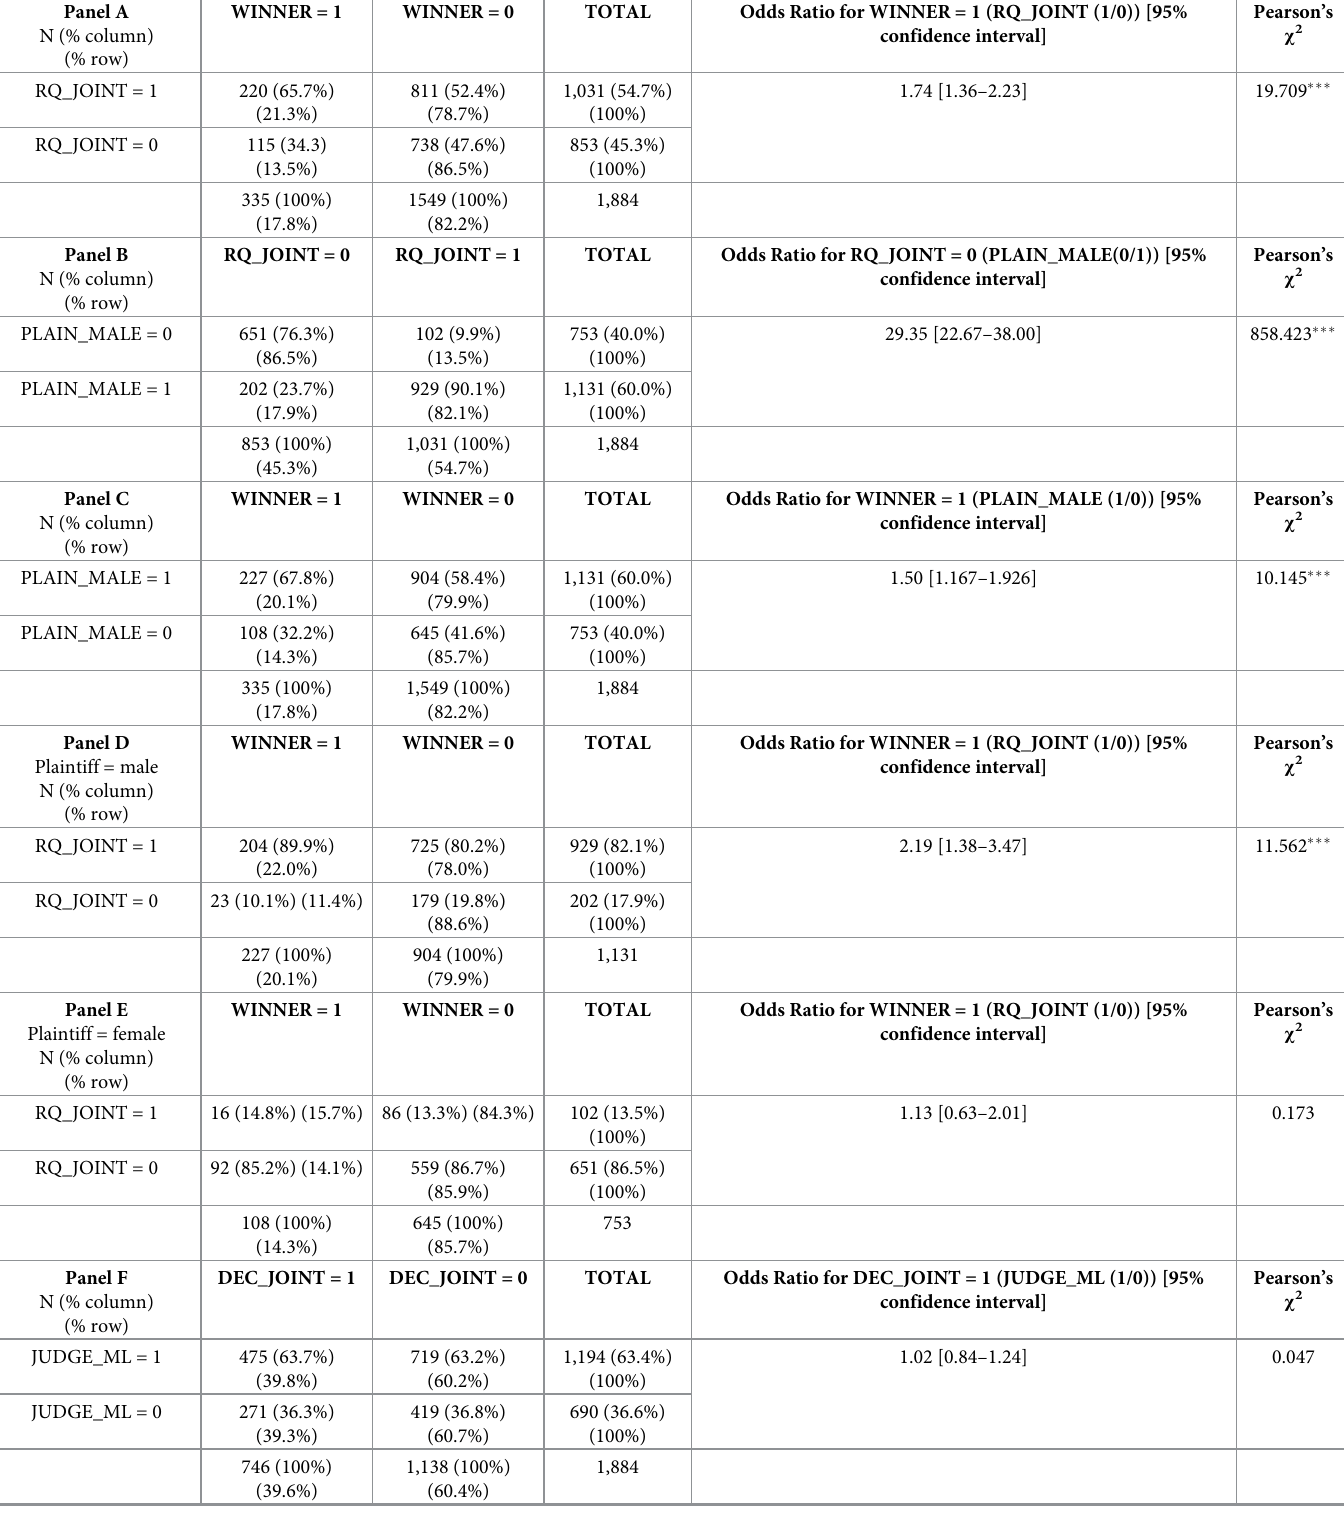
Table 5. Contingency tables, Chi-square test and odds ratios for categorical